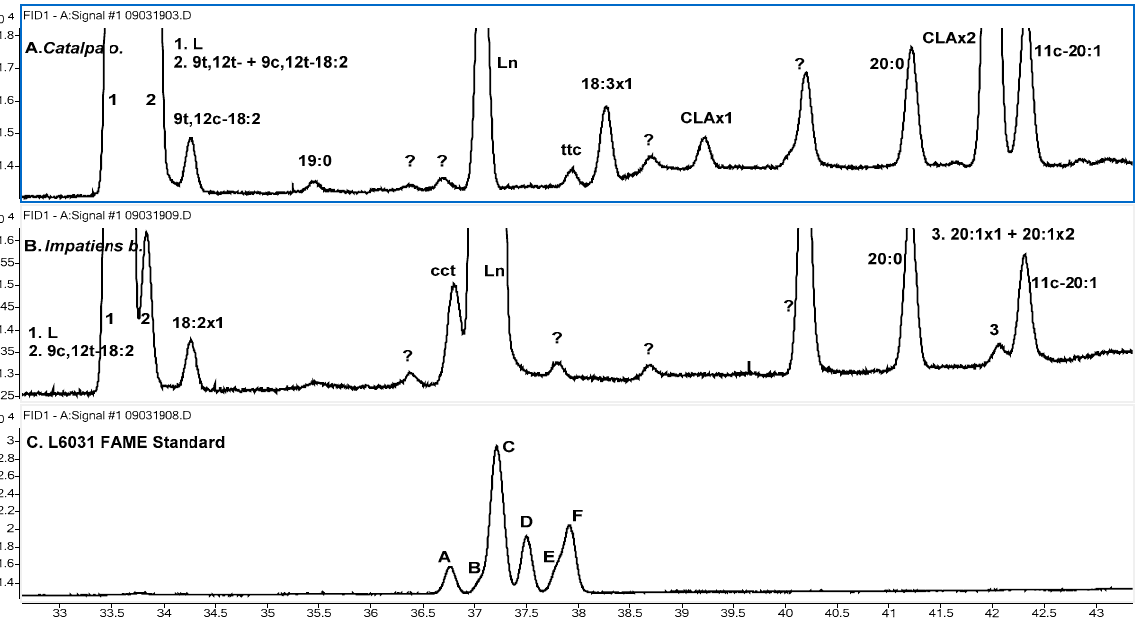
Figure 4. Chromatograms showing the 18:2 and non-conjugated 18:3 isomers on the Omegawax 250 column. ( A ) FID of Catalpa o. , ( B ) FID of Impatiens b. , and ( C ) FID of L6031 standard containing the eight geometric 9,12,15-18:3 isomers. The configuration of the L6031 peaks is A cct ; B ccc (shoulder); C ttt and (2 t , 1 c ); D (2 t , 1 c ); E (2 c , 1 t ) (shoulder); F ttc and (2 c , 1 t ). Peaks marked ‘ ? ’ in 4A and 4B are unknowns for which MS evidence is not sufficient to support identification. Peaks for 20:1x1 and 20:1x2 are not seen in the FID chromatogram for Catalpa o. (4A) due to co-elution with the larger CLAx2 peak.